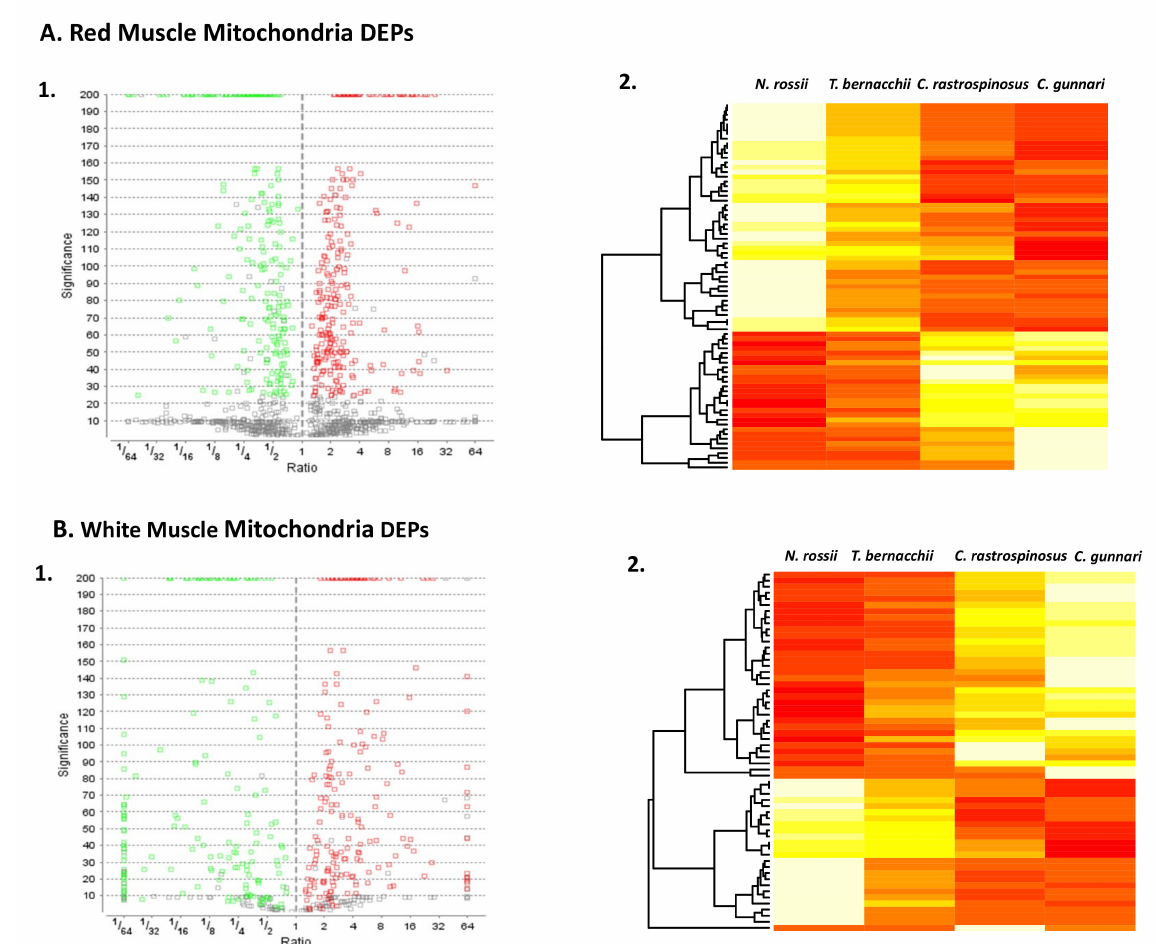
Figure 1. Volcano Plot and Heat Map of DEPs for the two tissue types. Volcano plot for differentially expressed proteins ( A1 , B1 ). The x axis depicts log fold change and y axis depicts FDR; the lower genes are low p values, less significant. Genes that are upregulated are on the right side of the graph and those that down regulate are on the left side of the graph (FDR > 0.01). DEPs in red muscle mitochondria ( A2 ) and white muscle mitochondria ( B2 ) for the four species (Red is significantly more highly expressed). The heat maps are produced using the relative percent of total ion area that is used for comparing the change in abundance for the same protein from different samples. A clear distinction in the expression of the protein abundance among different species can be seen, red being more abundant and yellow being less (List of proteins Tables